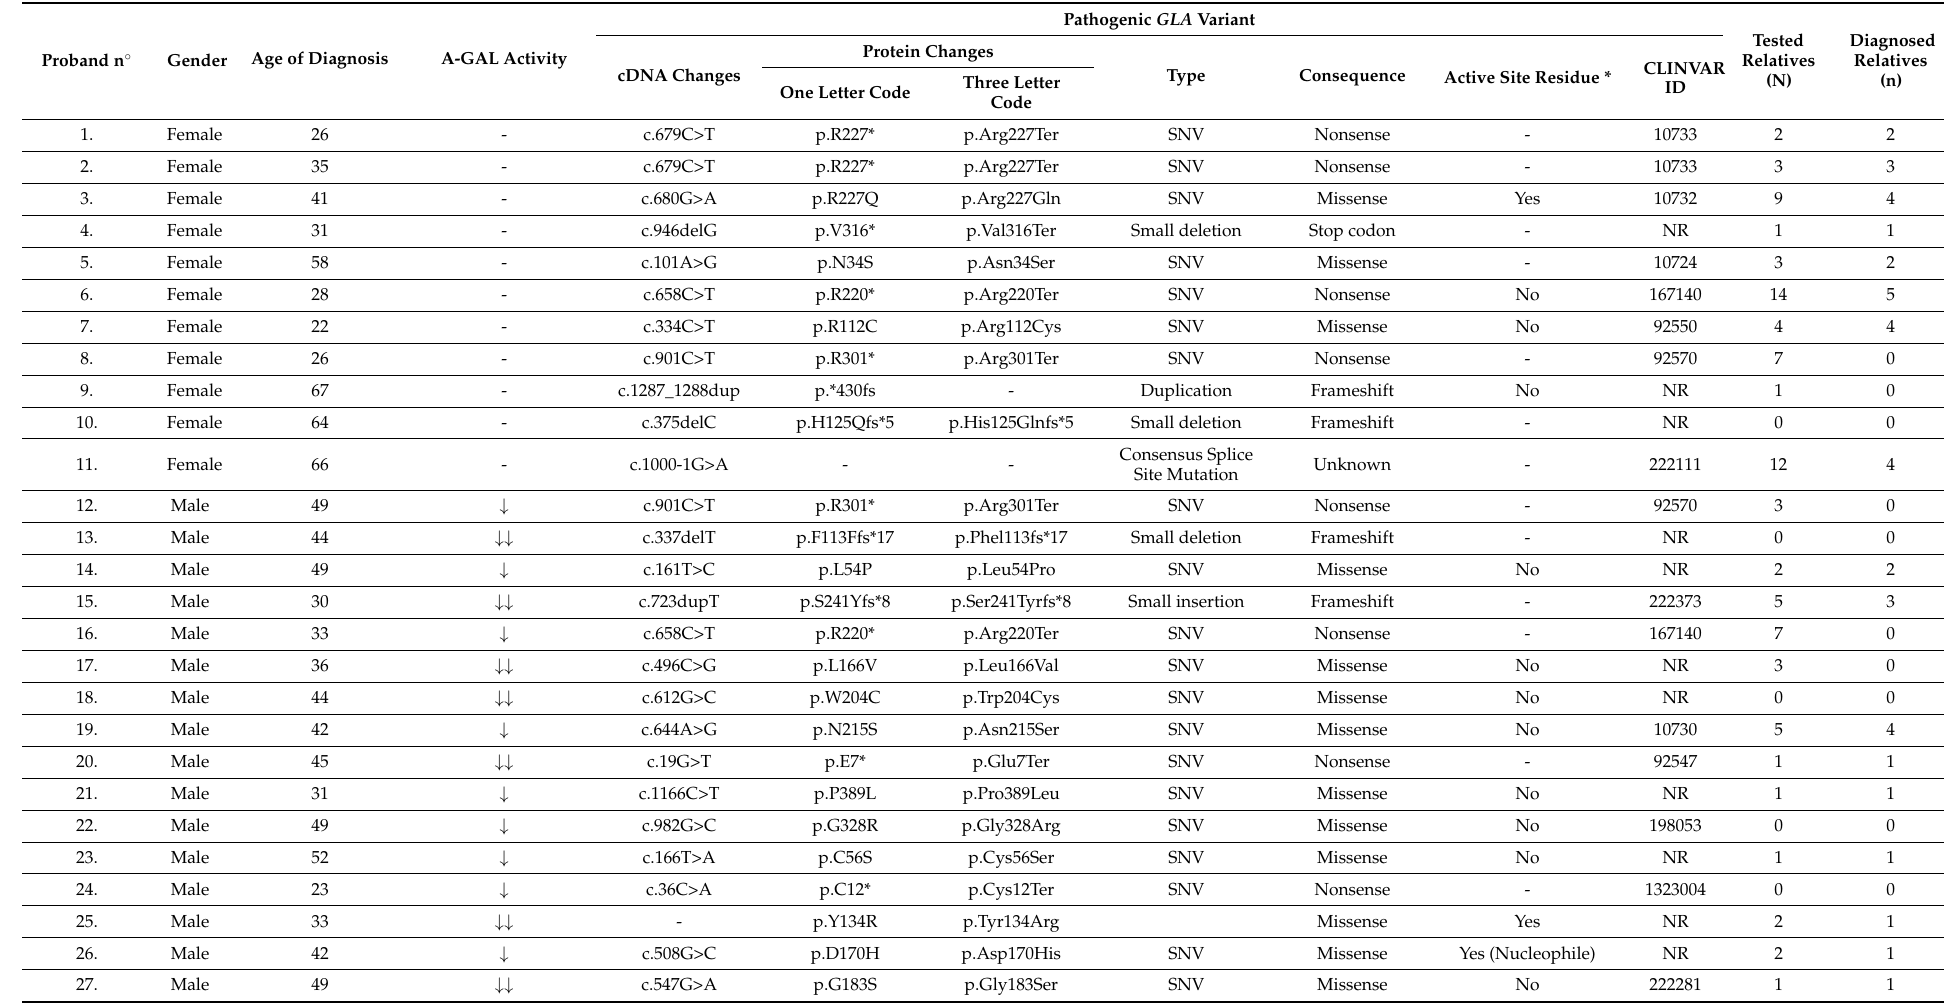
Table 3. List of GLA pathogenic variants identified in Russian patients diagnosed with Fabry disease ( n = 97 males and 195